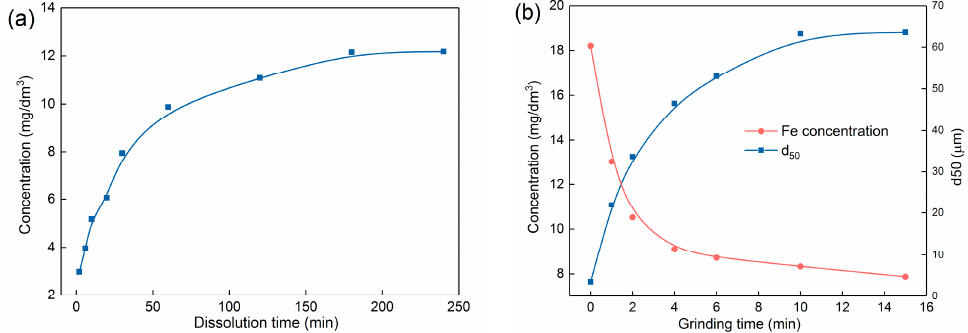
Figure 2. Concentration of Fe released from limonite as a function of ( a ) dissolution time and ( b ) grinding time.